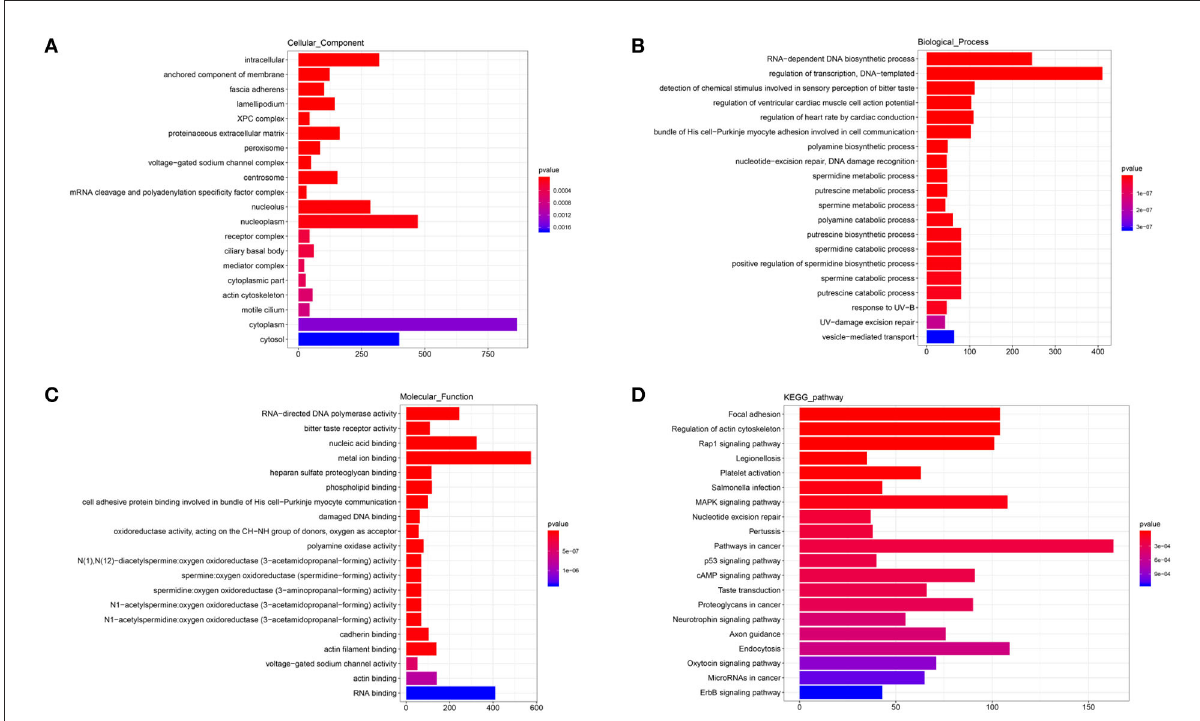
FIGURE6 GO and KEGG analysis of DElncRNAs. (A) Cellular component enrichment. (B) Biological process enrichment. (C) Molecular function enrichment. (D) KEGG